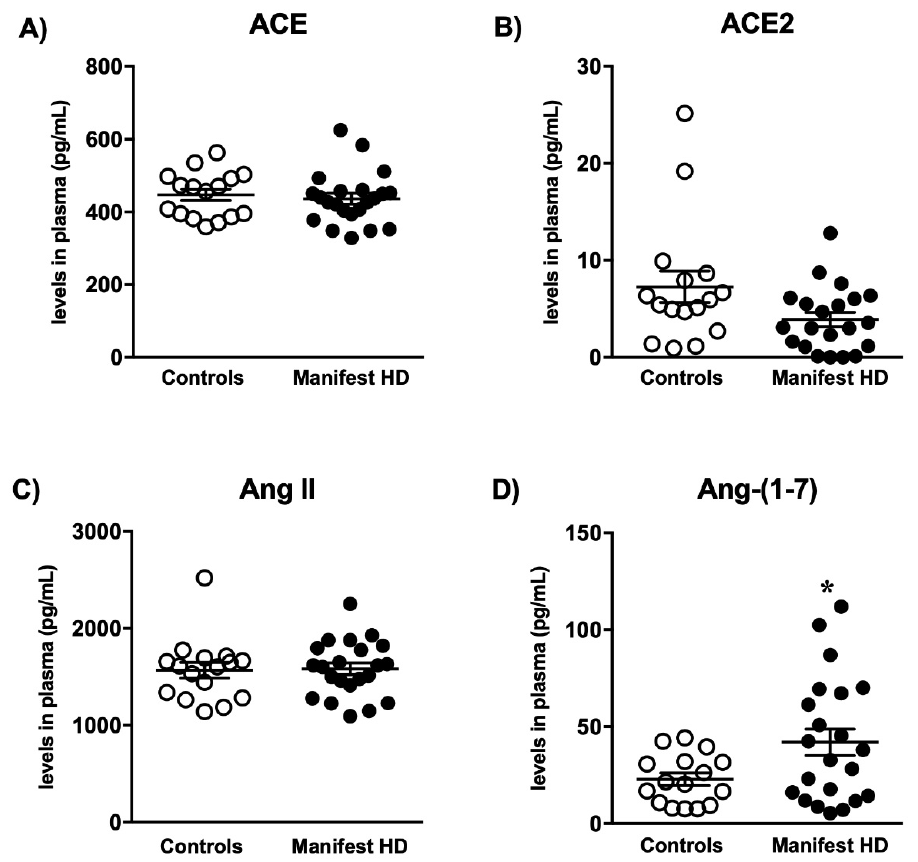
Figure 6. RAS components’ concentrations in the plasma of HD manifest and control patients. ( A ) ACE and ( B ) ACE2 levels, ( C ) Ang II and ( D ) Ang-(1-7) levels in the plasma of HD manifest and control patients. Results are expressed as mean ± SEM. n = 16–22. * p < 0.05 compared with the